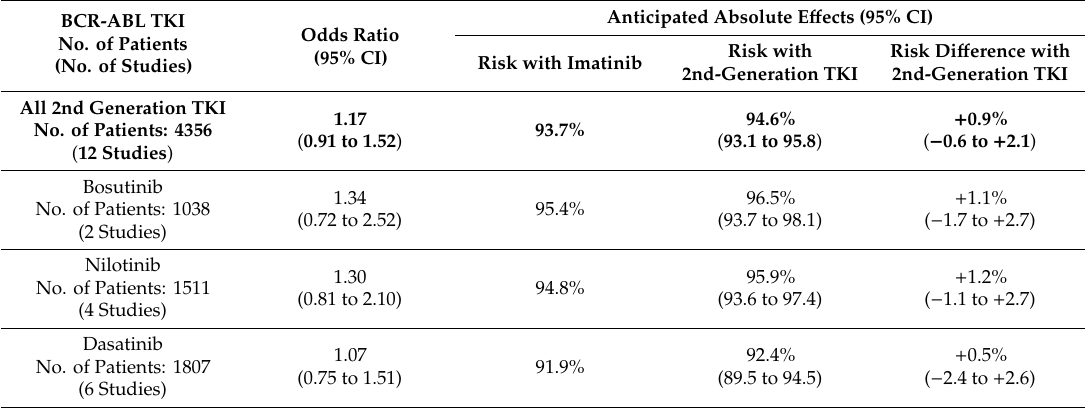
Figure 2. Forest plot of overall survival in patients with chronic myeloid leukemia (CML) treated with second-generation TKIs versus imatinib. Table 1. Overall survival in patients with CML receiving second-generation BCR-ABL TKIs. (The bold is a summary of the other rows.)